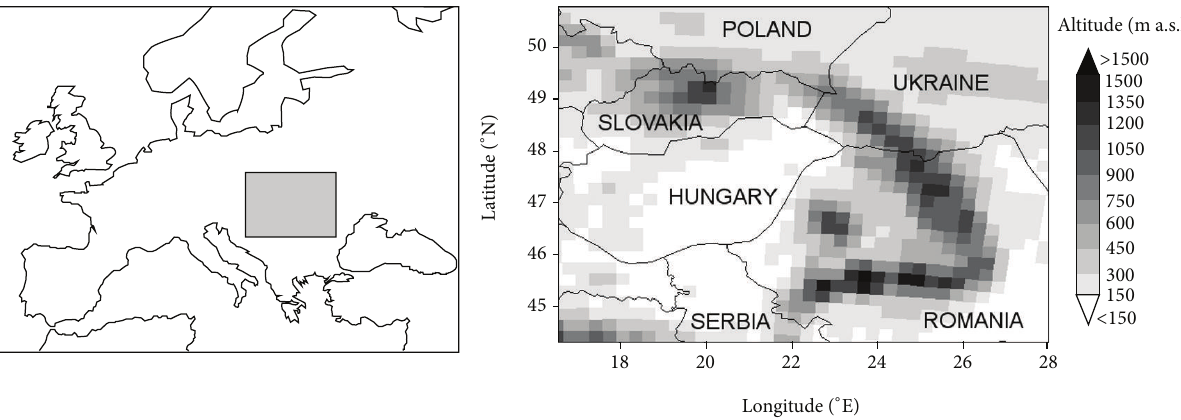
Figure 1: Carpathian Basin: the area under study (17–28 ∘ E, 44.5–50.5 ∘ N). Orography is taken from model RCA3.